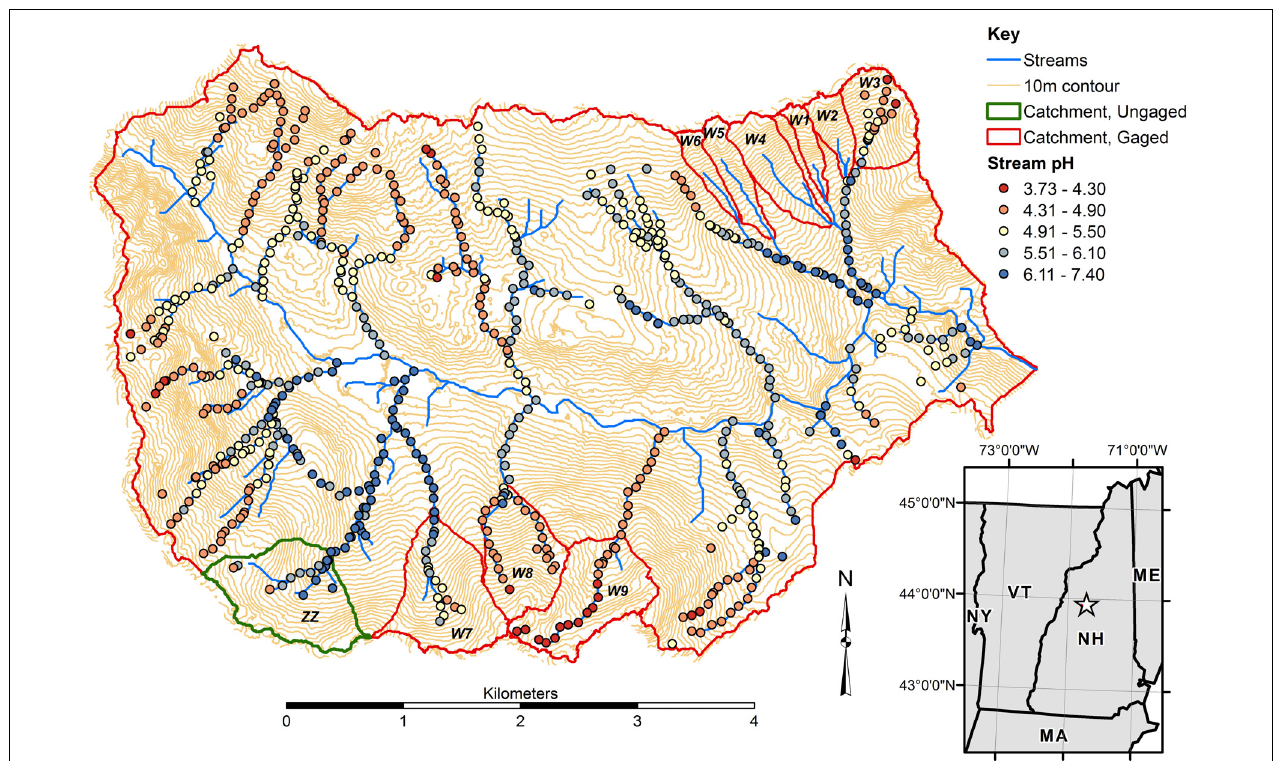
FIGURE 1 | Locus map and variation in surface water pH across the tributaries of Hubbard Brook. pH data are from Likens and Buso (2006), further described statistically by McGuire et al. (2014). Catchments considered in the present study include Zig Zag (ZZ) and Watershed 9 (W9) along the southern edge of the Hubbard Brook catchment and Watershed 3 (W3) at the northeastern